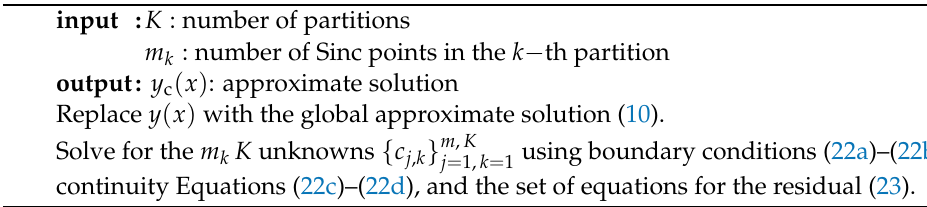
Algorithm 3: Piecewise Poly-Sinc Algorithm